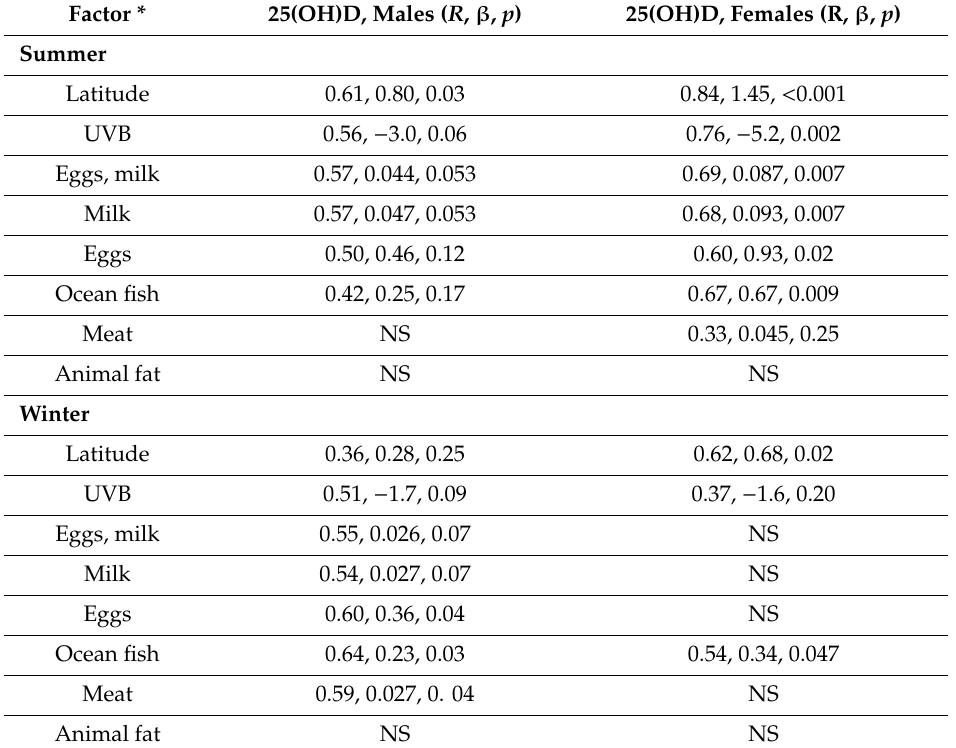
Table 4. Regression results for 25(OH)D for the set of 15 countries from the Middle East and Europe with respect to latitude, UVB dose, and dietary factors (Aug. 25).